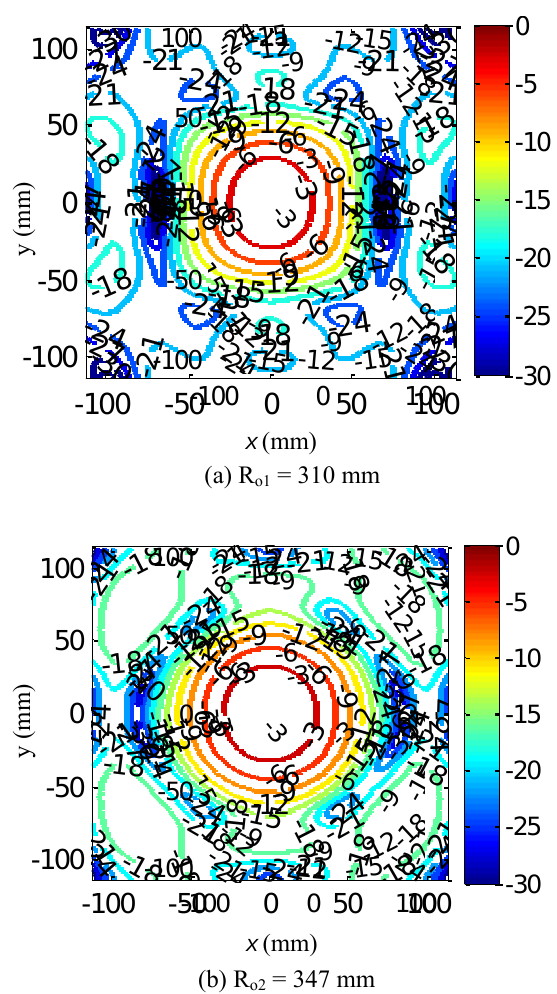
Figure 13: A contour plot of the simulated normalized power density of for the dual-focused transmitarray in a plane at (a) R o1 = 310 mm and (b) R o2 = 347